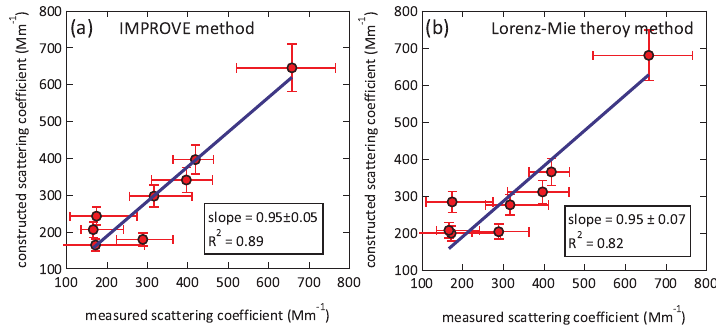
Fig. 4. Results of scattering closure calculation using both IMPROVE method (a) and Lorenz-Mie theory method (b) .